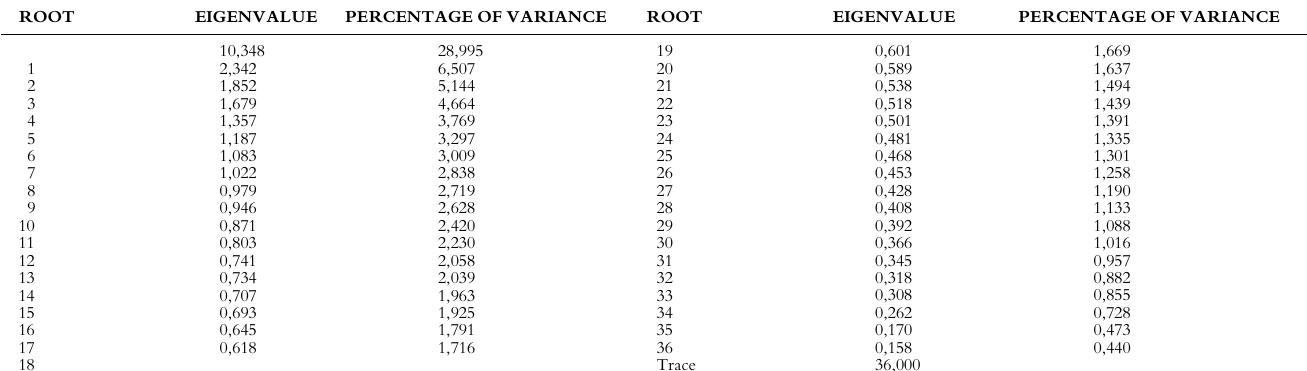
TABLE 2 EIGENVALUESOF UNREDUCEDINTERCORRELATION MATRIX